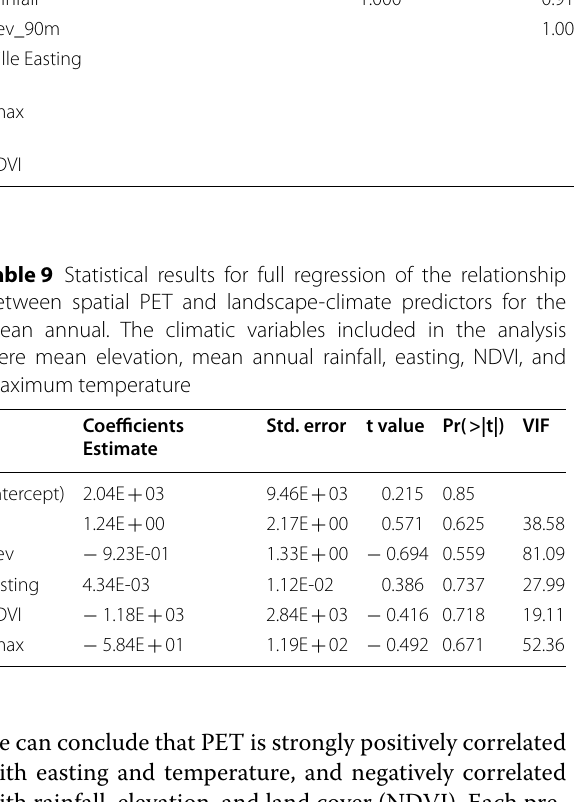
Table 8 Correlation matrix of PET versus landscape-climate predictor variables PET Rainfall elev_90m Mille Easting Tmax NDVI PET 1.000 Rainfall